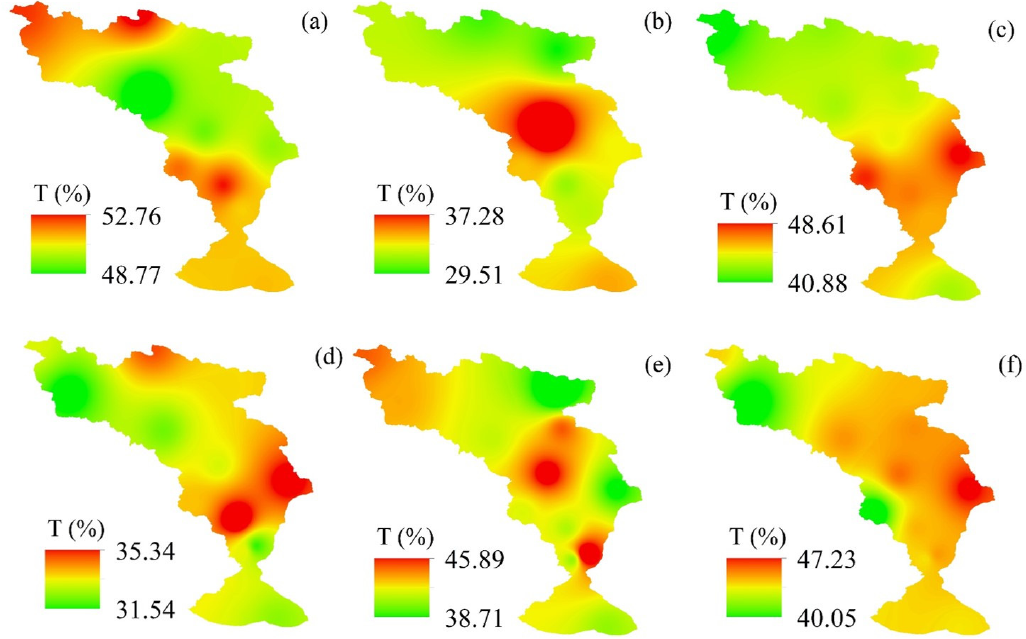
Figure 12. Spatial variation of plant transpiration ratio ( T ) in summer 2018 ( a – c ) and 2019 ( d – f ).